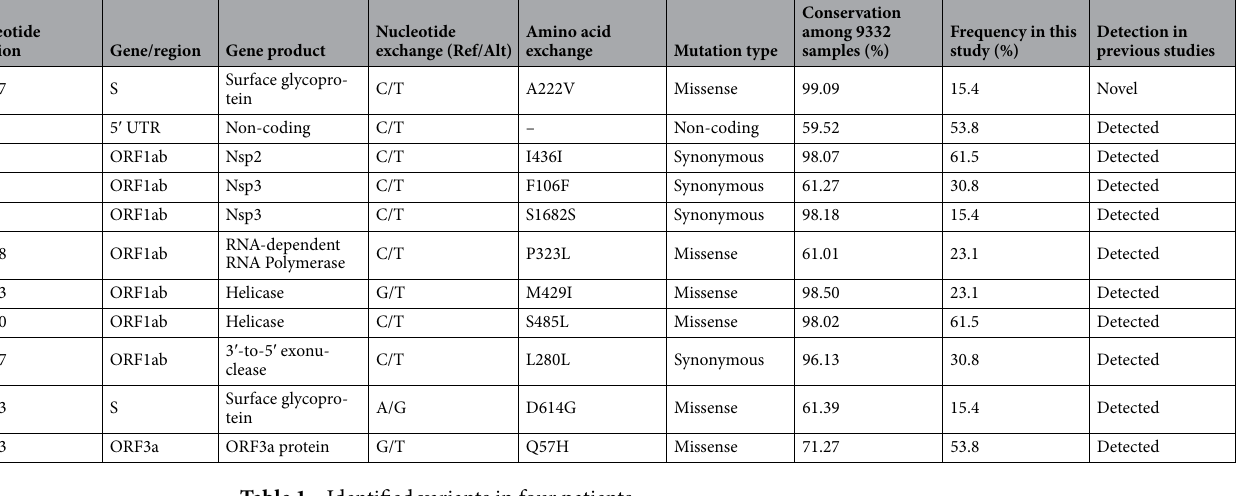
Table 1. Identified variants in four